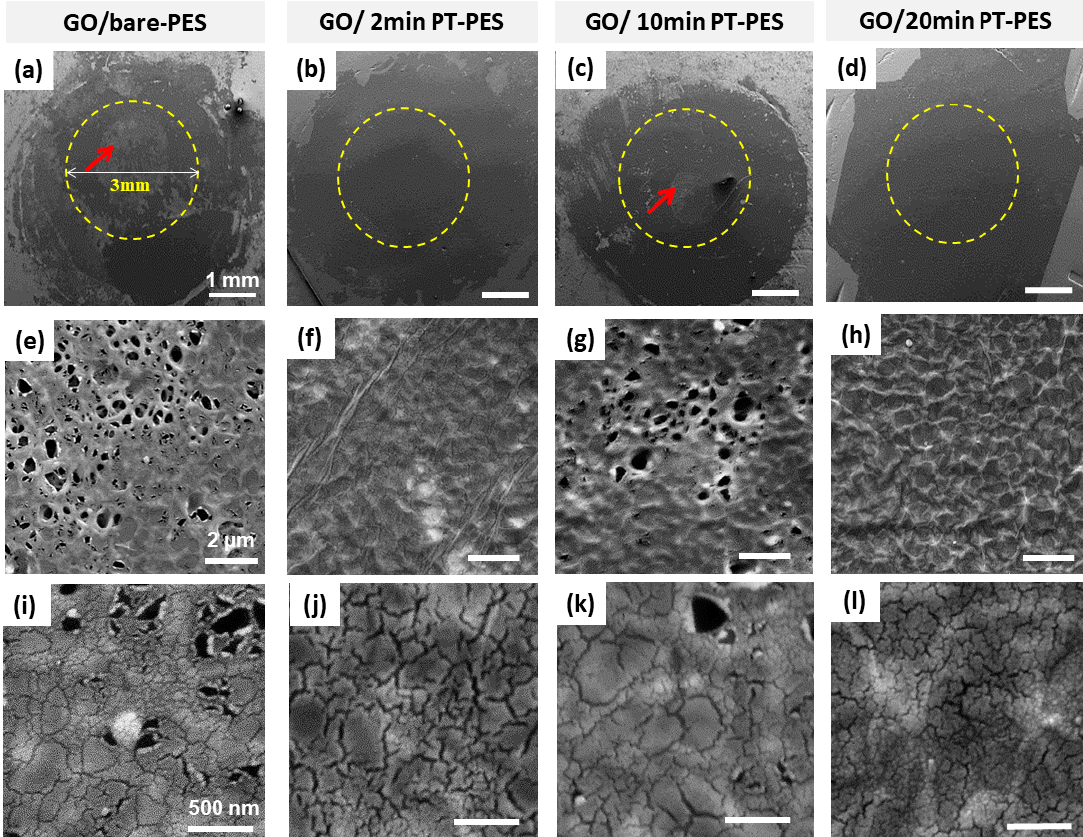
Figure 6. SEM micrographs of the GO/PT-PES membranes after the KCl ion diffusion study: ( a , e , i ) GO/bare-PES, ( b , f,j ) GO/2 min PT-PES, ( c , g , k ) GO/10 min PT-PES, and ( d , h , l ) GO/20 min PT-PES. Red arrows in panels ( a ) and ( c ) indicate the regions of detached GO flakes.